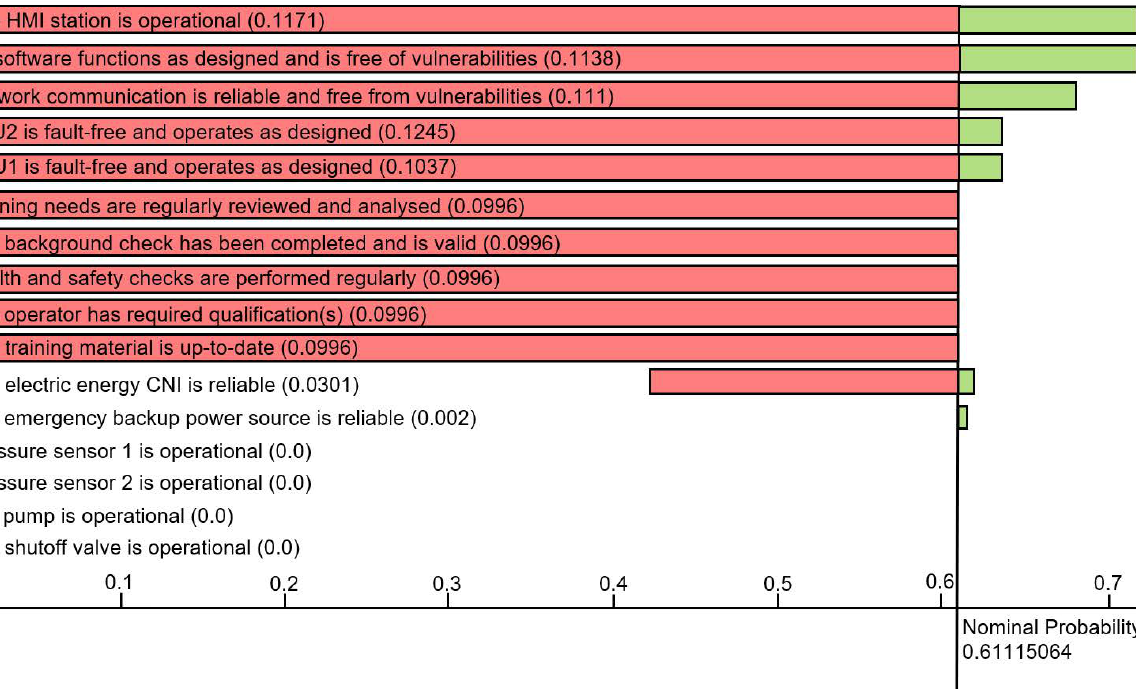
Figure 11. Updated Top-Level DM for the Water Distribution System.